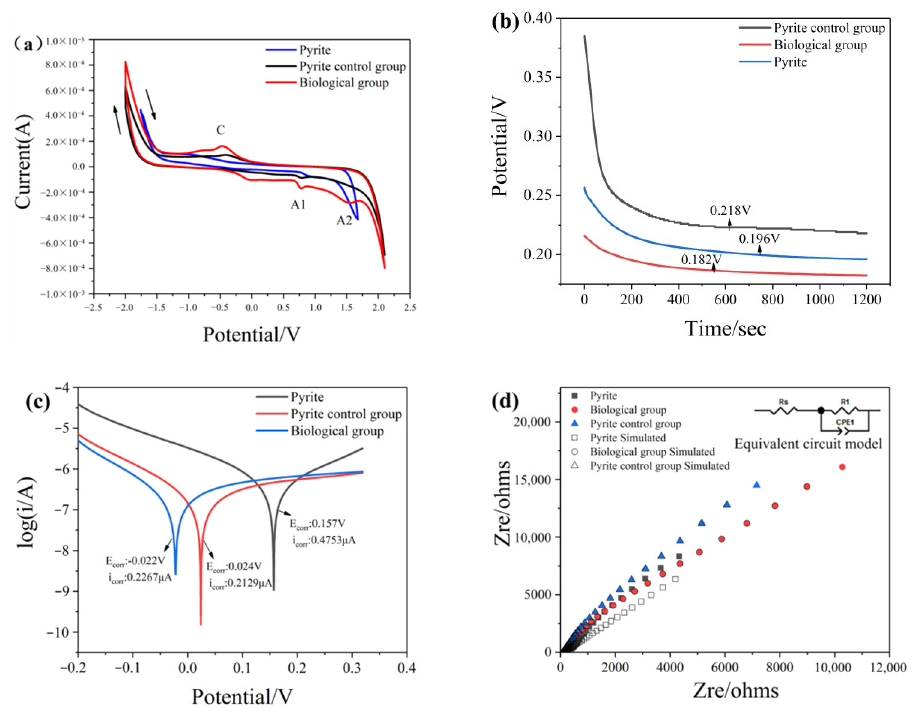
Figure 6. Electrochemical analysis of pyrite before and after treatment with or without chromium solution: ( a ) Cyclic voltammetry curves; ( b ) Open circuit potential; ( c ) Tafel curves; ( d ) Nyquist impedance spectra.